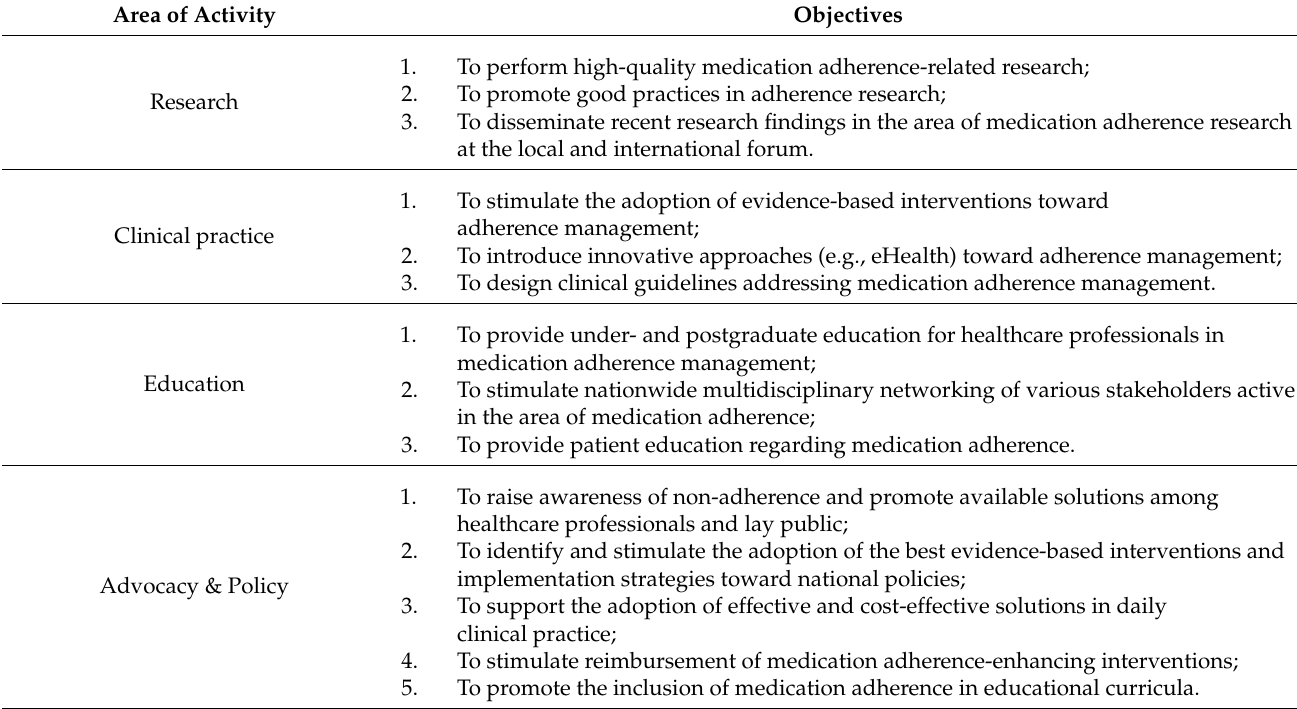
Table 1. The objectives of medication adherence research centres of excellence across various areas of their